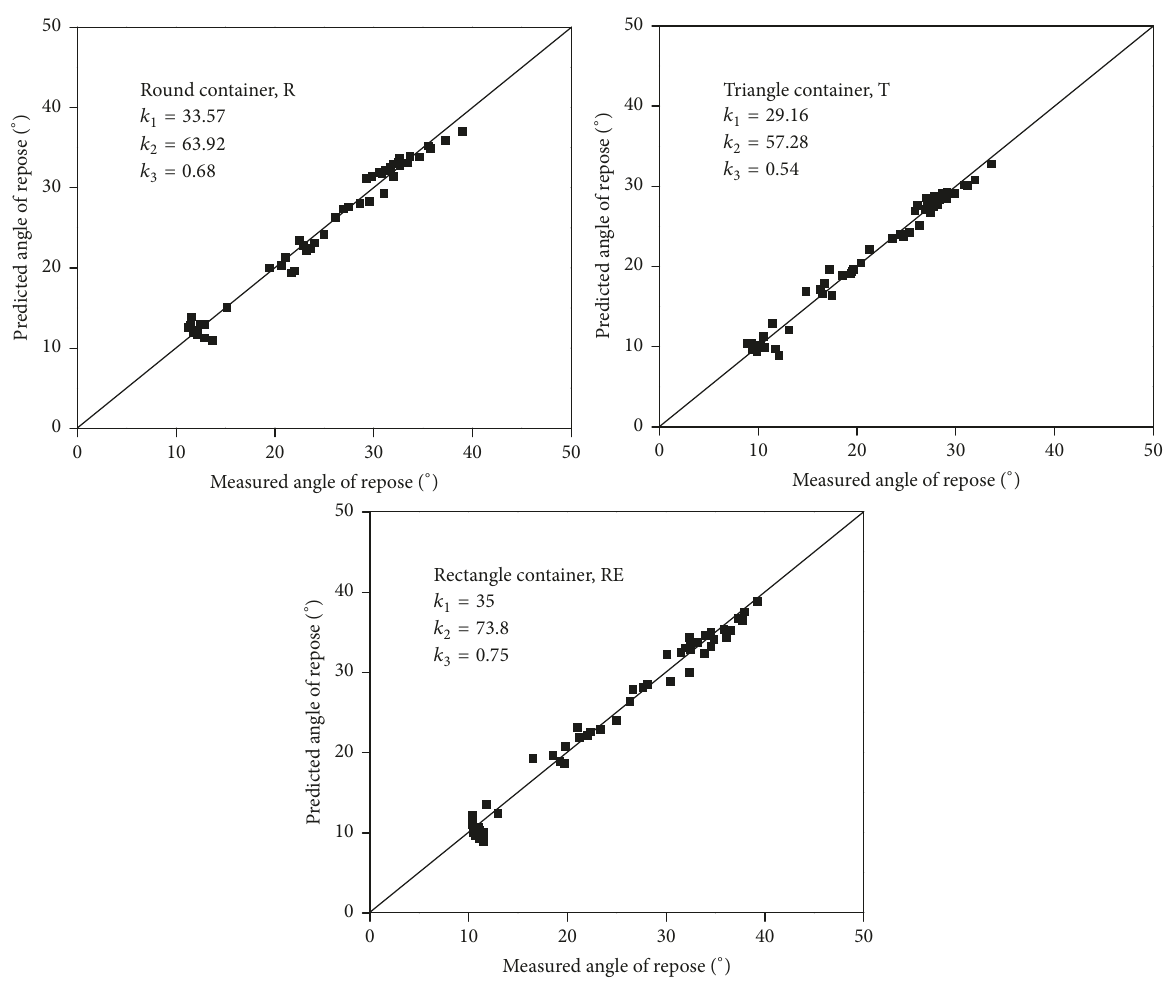
Figure 8: Effect of measured angle of repose with predicted angle of repose.